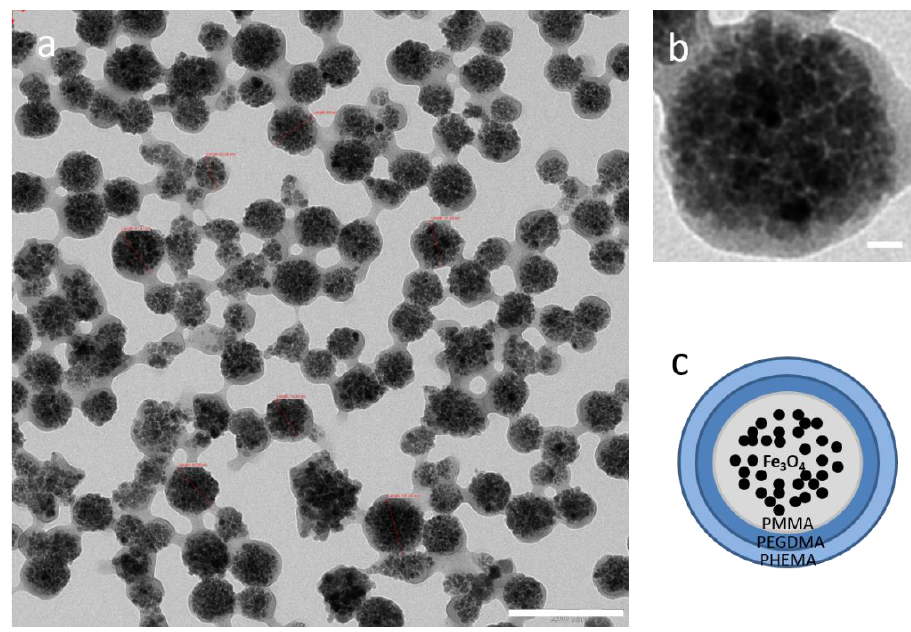
Figure 1. ( a ) TEM image of MagP ® – OH particles. Scale bar: 200 nm. ( b ) Detail of a single particle. Scale bar is 20 nm. ( c ) MagP ® – OH particle scheme.